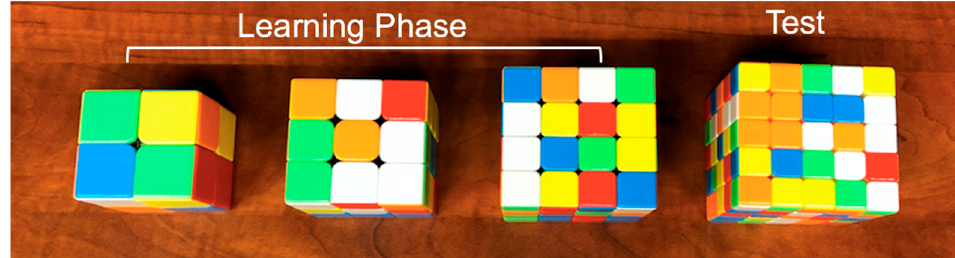
Figure 1. Consistent-order condition. Cube sizes are identical across the learning phase and at test (5 × 5 × 5).